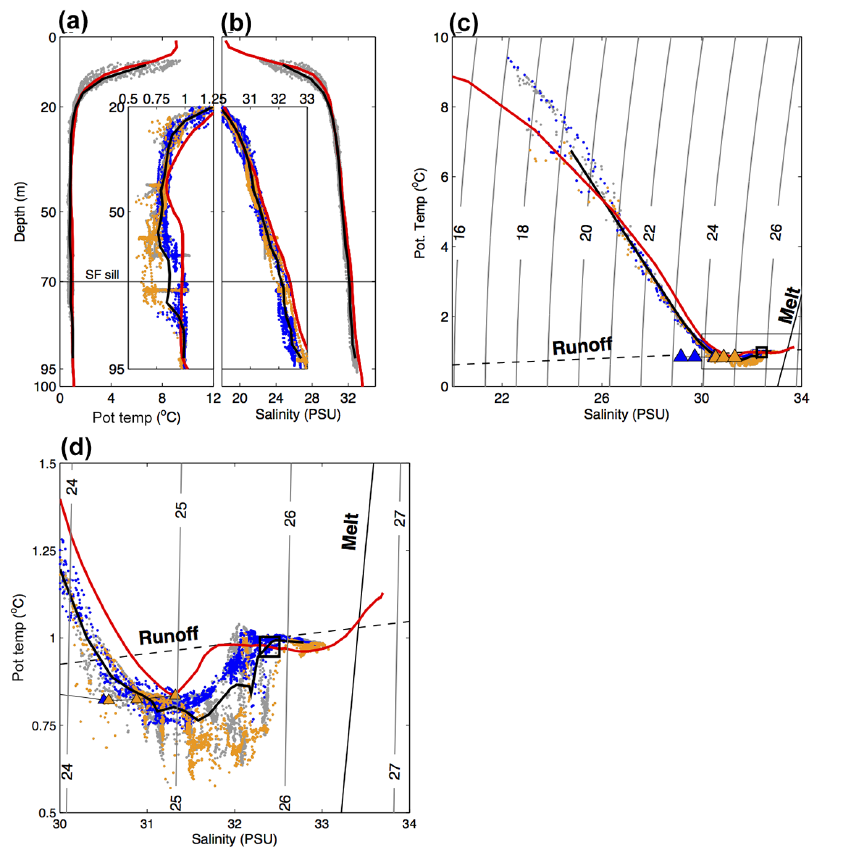
Figure 5. Glacially modified water in Sarqardleq Fjord. θ ( ◦ C) (a) and S (b) profiles for R4 and R5 measurements over the full water-column depth (grey), with the average of R4 and R5 measurements and the ambient fjord waters in black and red, respectively. (a) and (b) insets show same data from 20–95m depth over a finer θ or S range, with measurements taken within the GMW1 and GMW2 regions along R4 and R5 (Fig. 3) shown in blue and gold, respectively. θ/S plots of R4 and R5 measurements (c) (colors same as in a and b ), with melt and runoff mixing lines. Intersection for melt and runoff mixing lines set to CTD2 properties at grounding line depth (Fig. 6b). Black square along ambient fjord water profile shows θ/S properties at sill depth (70m). θ/S results for the Jenkins (2011) plume modeling (Table 4) of D1 (blue triangles) and D2 (gold triangles) shown. (d) Same data as in (c) over finer θ/S range indicated by thin black box in (c)